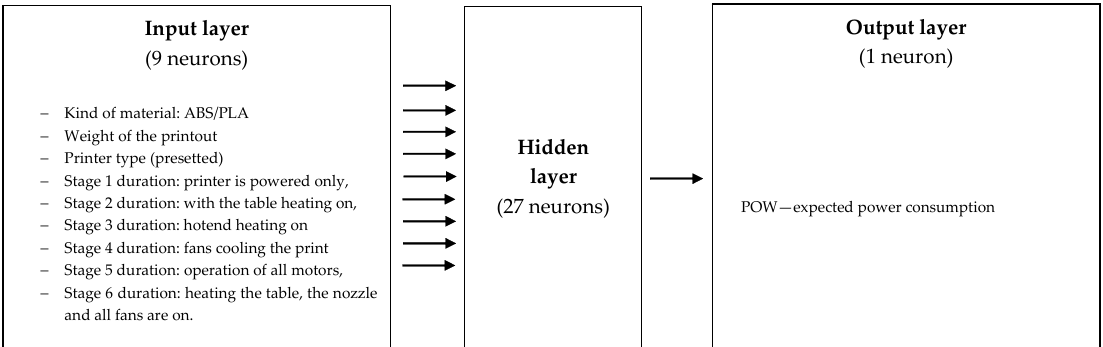
Figure 1. Artificial neural network 1 ( ANN1) optimal structure for evaluating energy consumption: inputs and outputs.